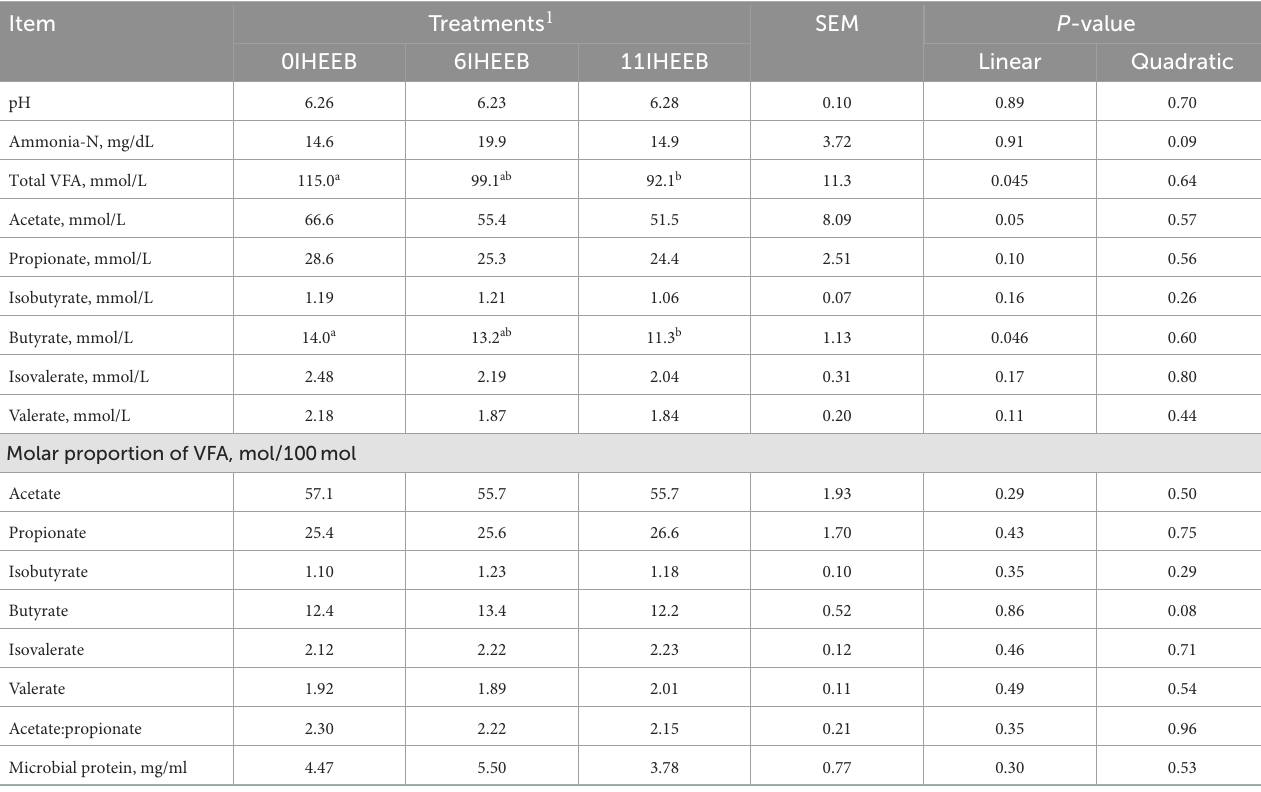
TABLE 5 Ruminal fermentation and microbial protein synthesis in Holstein cows fed 3